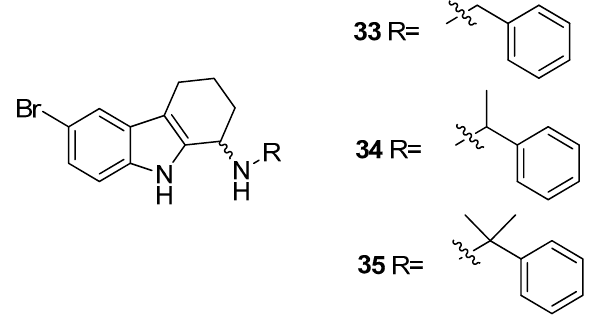
Figure 15. Structures of N -benzyl-6-bromotetrahydrocarbazoleamine ( 33 ), N - α -methylbenzyl-6- bromotetrahydrocarbazoleamine ( 34 ) and N -dimethylbenzyl-6-bromotetrahydrocarbazoleamine ( 35 ).